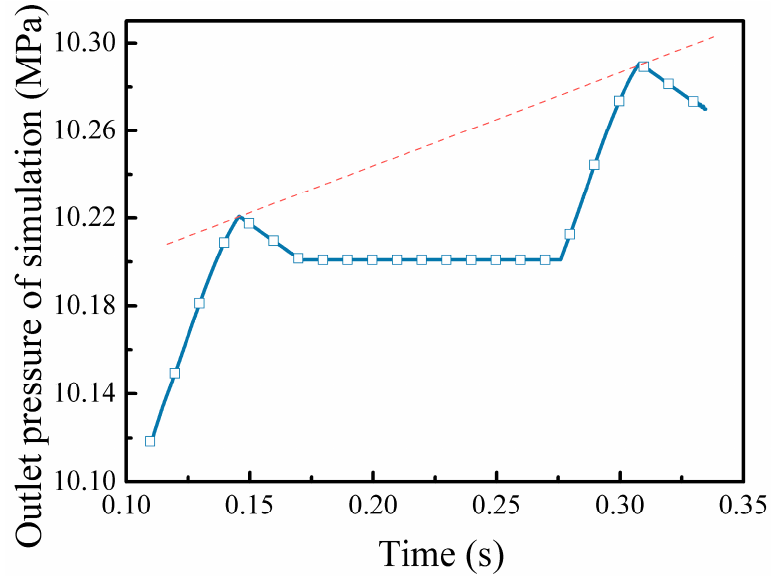
Figure 18. Two-cycle simulated boost curve.